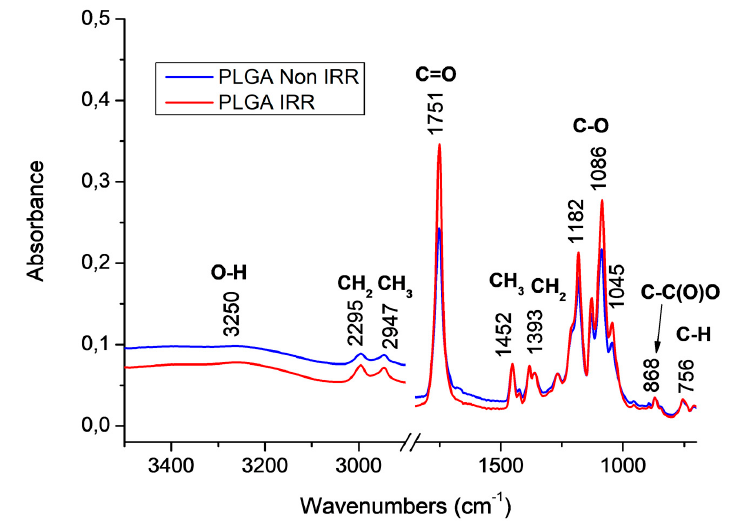
Figure 6. Normalized FTIR using the attenuated total reflection mode (FTIR-ATR) spectra of PLGA nonwovens before and after gamma irradiation.